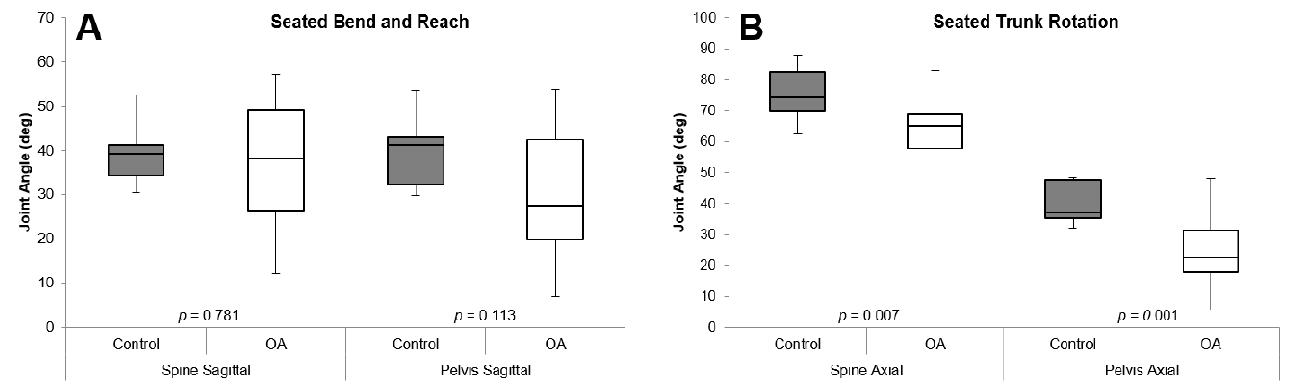
Figure 5. ( A ) Seated bend and reach (SBR) task range of motion (ROM) of the sagittal spine and pelvis assessments; ( B ) seated trunk rotation (STR) task axial ROM of the spine and pelvis for the control (dark grey) and osteoarthritis (OA) (white) participants.